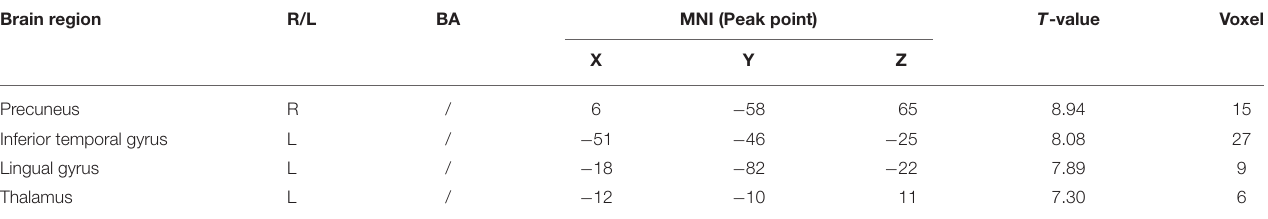
TABLE 3 | Regions showing significant fALFF value changes between the treatment group and control group. Brain